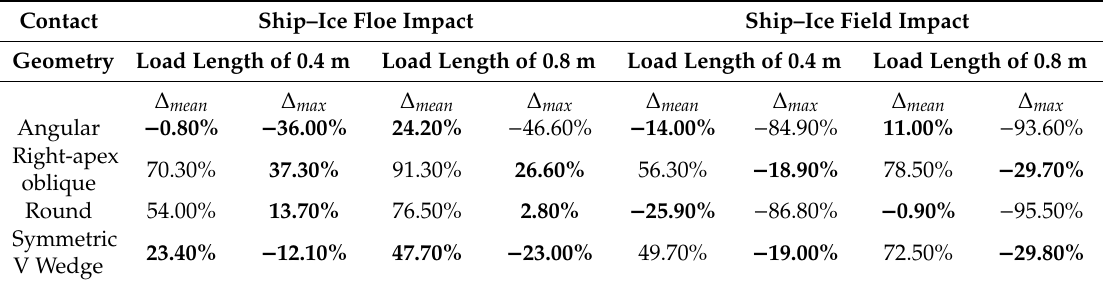
Table 4. Percentage-deviations between loads calculated for various collision scenario assumptions and the measured values of data set B. (Bold font indicates that the deviation is below ± 40%.) Contact Ship–Ice Floe Impact Ship–Ice Field Impact Geometry Load Length of 0.4 m Load Length of 0.8